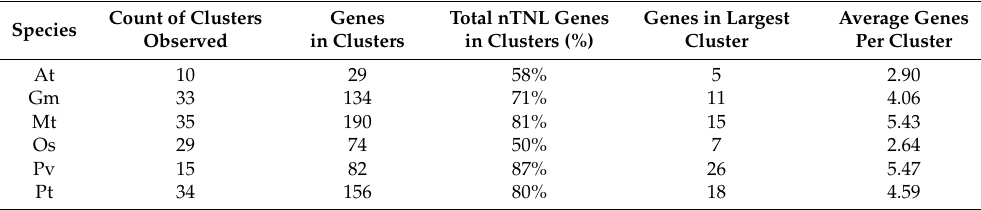
Table 4. Gene clustering in six plant genomes as predicted by 200 kb sliding windows. (At = A. thaliana , Gm = G. max , Mt = M. truncatula , Os = O. sativa , Pv = P. vulgaris , and Pt = P. trichocarpa ).